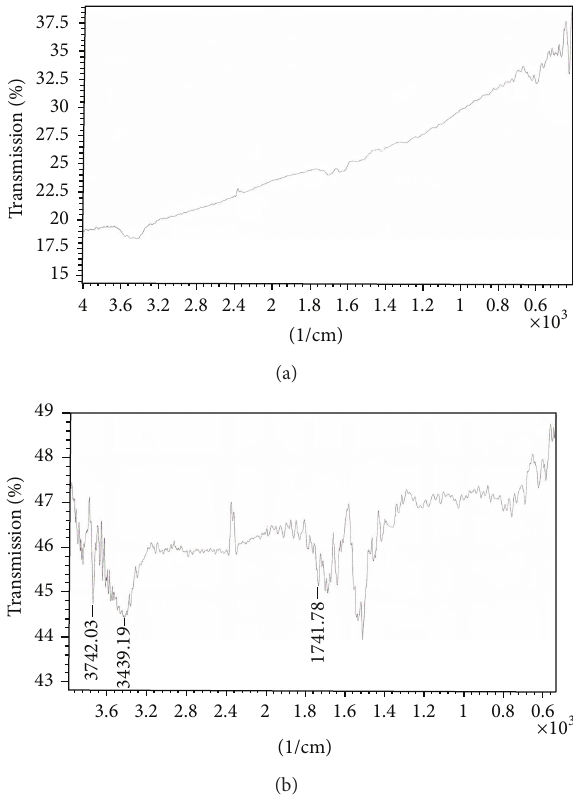
Figure 4: (a) FTIRof as-produced CNTs. (b)FTIRof functionalized CNTs.